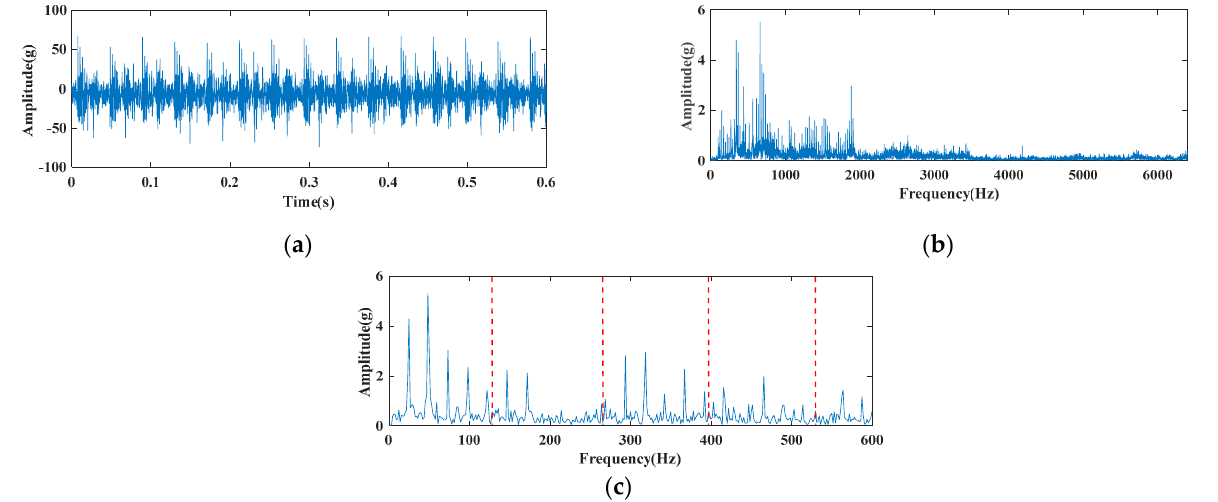
Figure 14. Experimental signal of bearing inner race single fault: ( a ) waveform; ( b ) frequency spectrum; ( c ) envelope spectrum.